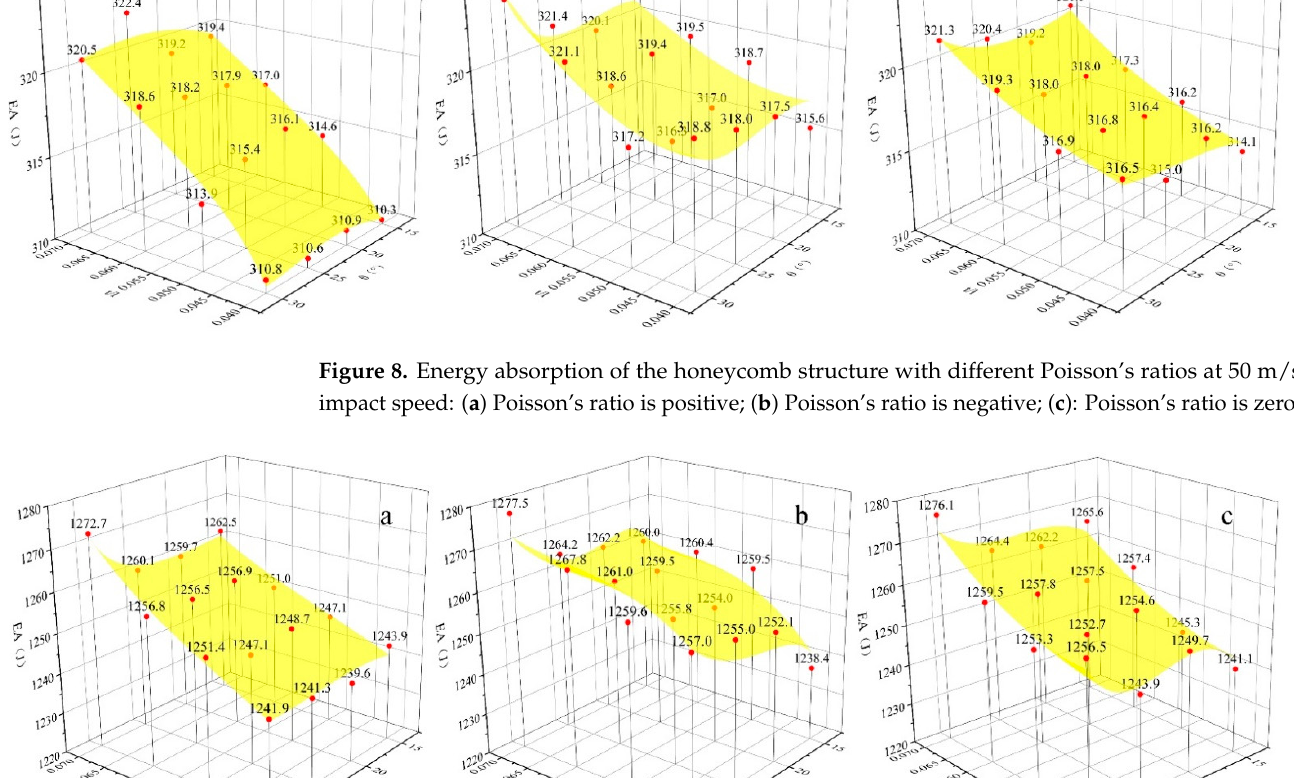
Figure 7. Energy absorption of the honeycomb structure with different Poisson’s ratios at 25 m/s impact speed: ( a ) Poisson’s ratio is positive; ( b ) Poisson’s ratio is negative; ( c ): Poisson’s ratio is zero.